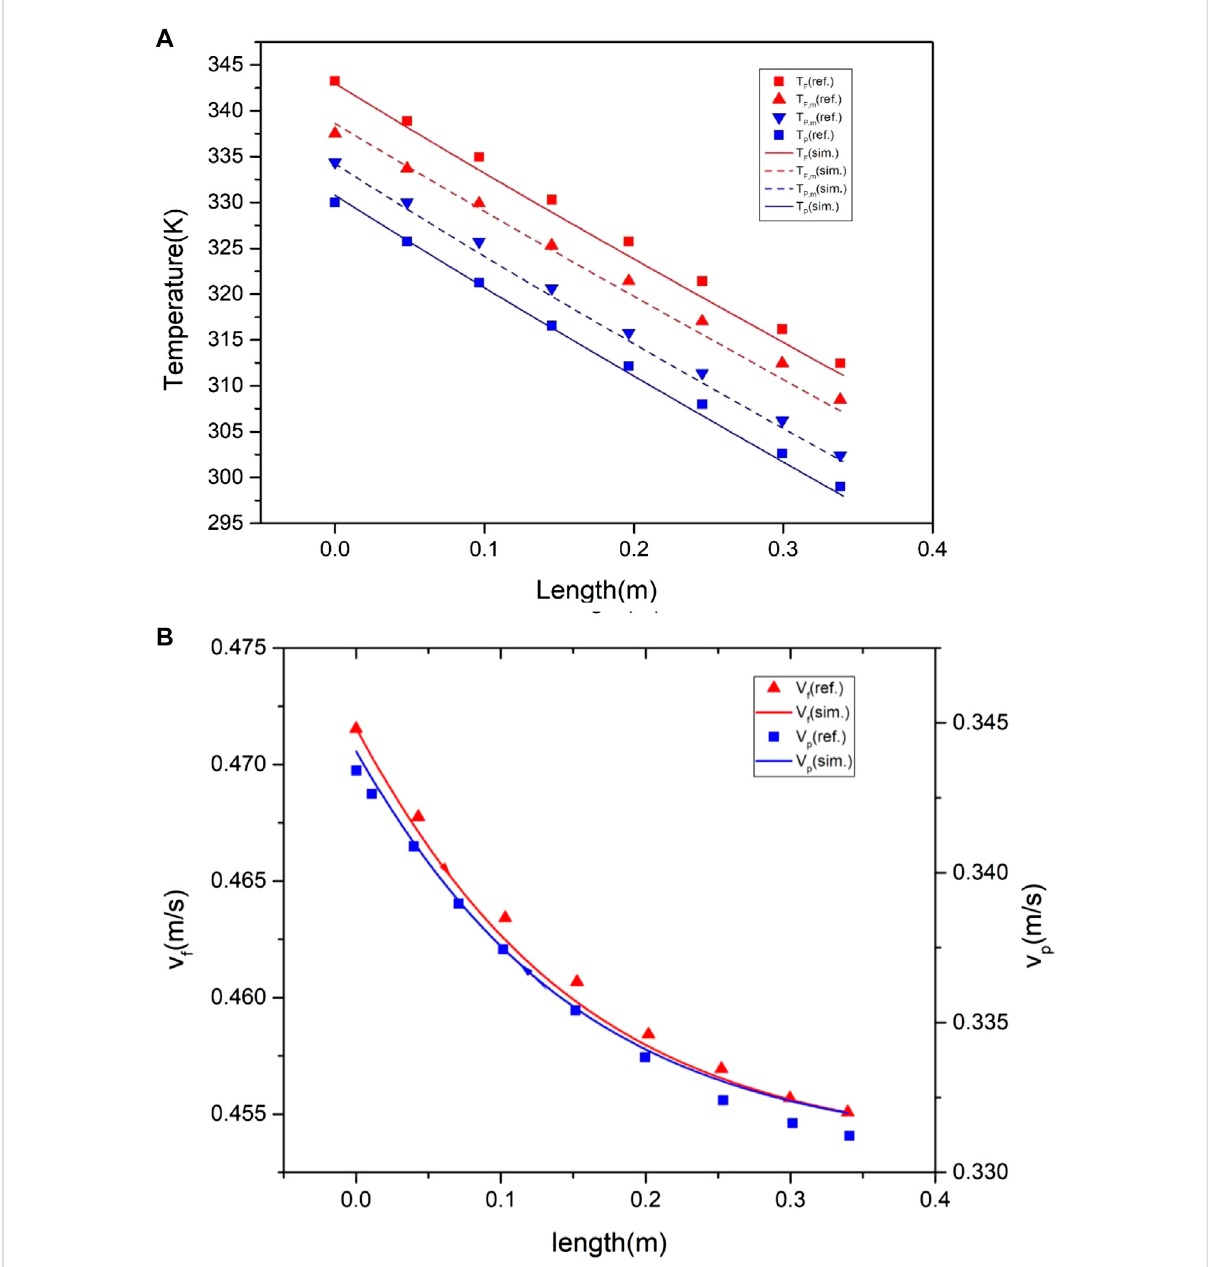
FIGURE 3 Validation of the numerical model for DCMD: (A) temperature pro fi le and (B) velocity pro fi le